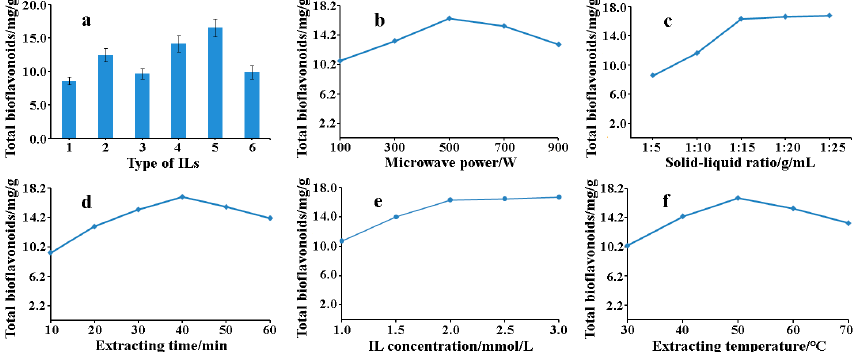
Figure 2. Effect of types of ILs ( a ). 1. (Bmim) (OAC), 2. (Bmim) (BF 4 ), 3. (Bmim) (Br), 4. (Bmim) (PF 6 ), 5. (Hmim) (PF 6 ), 6. (Omim) (PF 6 ). Extraction parameters were as follows: 10 g S. doederleinii , IL concentration of 2.0 mmol/L, ratio of solution to raw of 1:10 g:mL, microwave power of 500 W and extraction time of 10 min. Effects of extraction parameters on total biflavones yields of S. doederleinii extracts: ( b ) Effect of microwave power on total biflavones yields; ( c ) Effect of solid-liquid ratio on total biflavones yields; ( d ) Effect of extraction time on total biflavones yields; ( e ) Effect of ILs concentration on total biflavones yields; ( f ) Effect of extraction temperature on total biflavones yields.